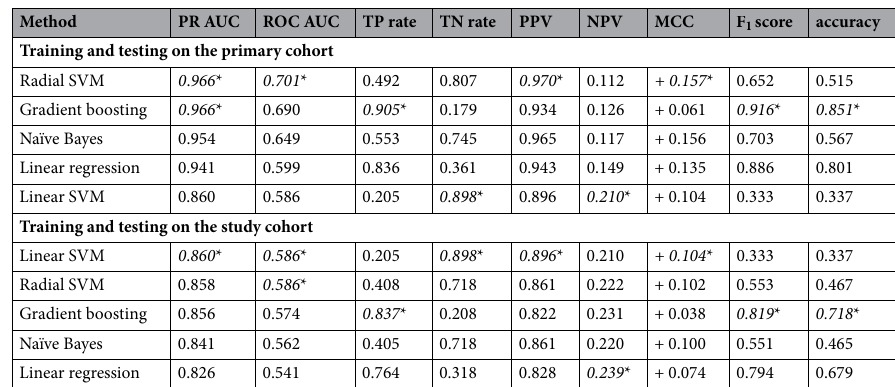
Table 5. Results of the survival prediction made with machine learning classifiers, with training phase and testing phase done on the Norwegian primary cohort or study cohort 87 . Mean results of 100 executions with random selection of the elements in the training set and test set, with ROSE oversampling 97 applied to the training set. Admissions of survived patients: positives data instances (class 1). Admissions of deceased patients: negative data instances (class 0). Linear SVM: support vector machine with linear kernel. Optimized cost regularization hyper-parameter of the linear SVM, most frequently selected C by the MCC-based grid search: C = 0.01 for primary cohort (63 times out of 100) and C = 0.001 for study cohort (51 times out of 100). Radial SVM: support vector machine with radial Gaussian kernel. Optimized cost regularization of the radial SVM, most frequently selected C by the MCC-based grid search: C = 0.1 for the primary cohort (56 times out of 100) and for the study cohort (51 times out of 100). MCC: Matthews correlation coefficient. MCC worst value = − 1 and best value = + 1 . TP rate: true positive rate, sensitivity, recall. TN rate: true negative